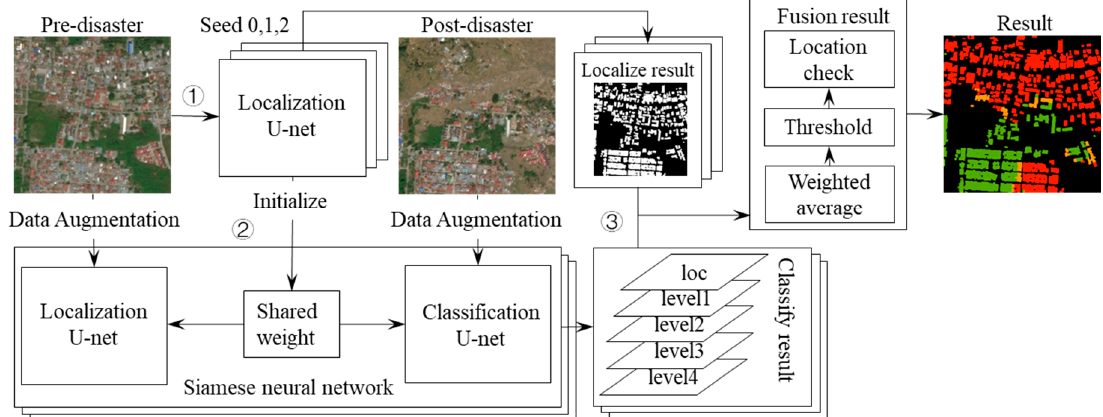
Figure 2. The overall framework. Localization U-Net is used to locate buildings . After pre-training with pre-disaster im- age, it shares weight with classification U-Net, which is used to classify damage level. The combination of the two is Siamese neural network. We use three random seeds to train it. After inputting pre- and post- disaster images into Siamese neural network, we get three five channels classification results. The first channel is the result of localization, and the last four channels are the probability of each damage level at each location. In the fusion step, the results corresponding to the three seeds are first weighted and averaged, and the weight is determined by the validation accuracy during the training process. Then, the threshold is used to determine the value of each pixel. Finally, for improving the accuracy, the pre- trained classification U-Net localizes the buildings again and get the localize result which be used for the double check of buildings’ localization.